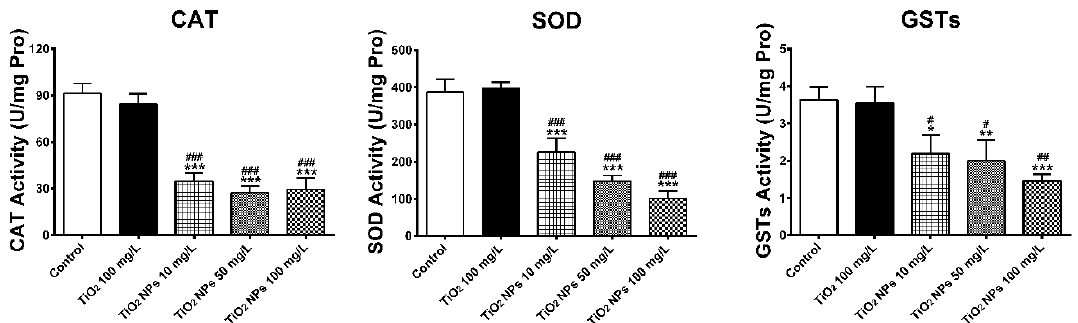
Figure 4. CAT, SOD and GSTs activities in zebrafish liver tissues. Data are expressed as means ± SD ( n = 3). *, ** and *** indicate statistically significant differences from control values at p < 0.05, p < 0.01 and p < 0.001, respectively. #, ## and ### indicate statistically significant differences from TiO 2 (100 mg/L) values at p < 0.05, p < 0.01 and p < 0.001, respectively.